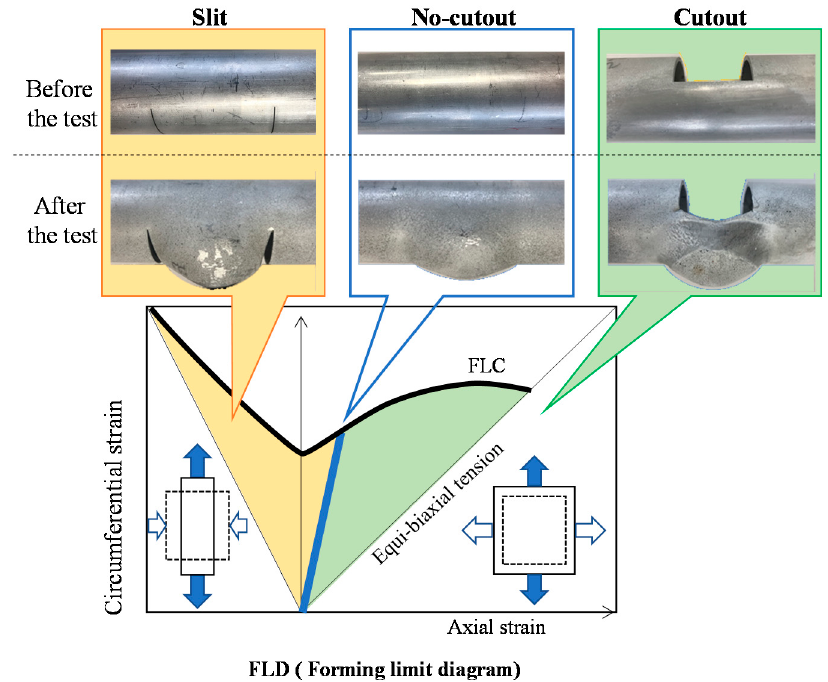
Figure 2. Change of strain path by introducing a cutout or slits to the tube specimen.